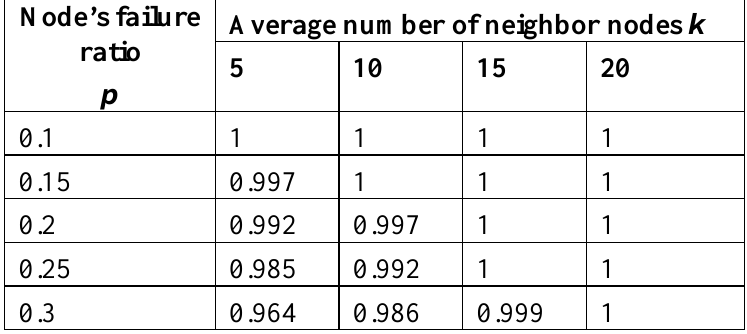
Table 2. Fault detection accuracy of improved DFD